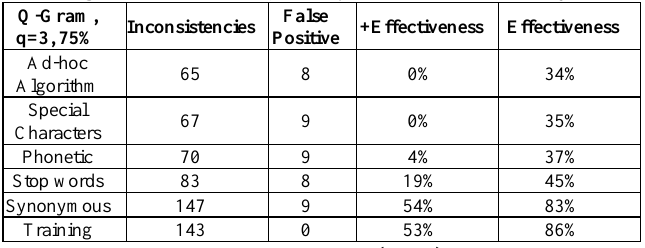
Table 5: Results obtained with data cleaning process using the algorithm Q-Grams, with q=3 and 75% similarity.